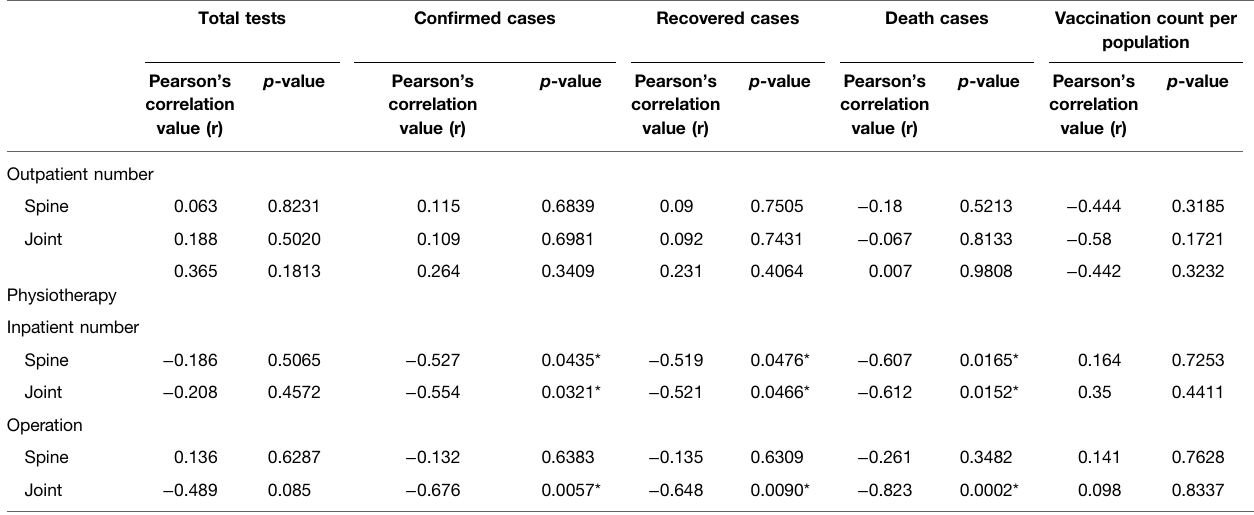
TABLE 3 | Pearson ’ s correlation of COVID-19 counts and orthopedic clinics in the United Arab